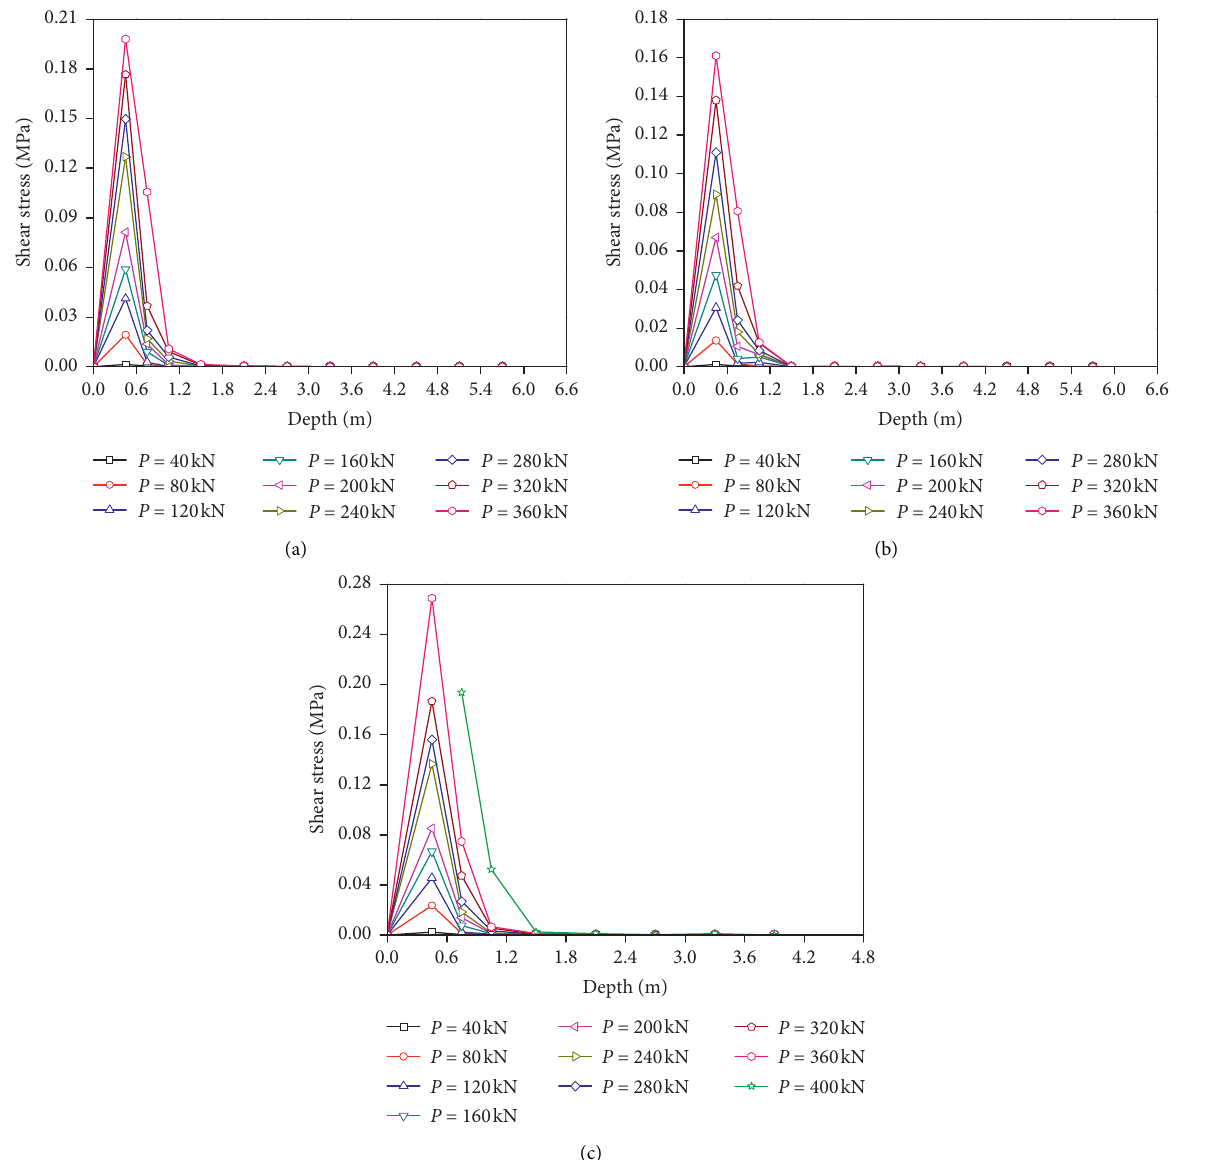
Figure 15: Shear stress of the middle interface at different depths: (a) G-28-6.5-1, (b) G-28-6.5-2, and (c)